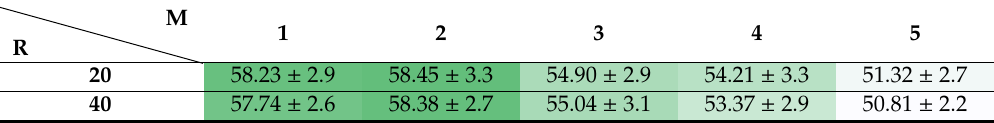
Table 2. The percentage of seed moisture change following the completion of washing as a function of maturity class, M (1–5) and applied ratio of water, R (20 or 40 mL), per gram of seed.